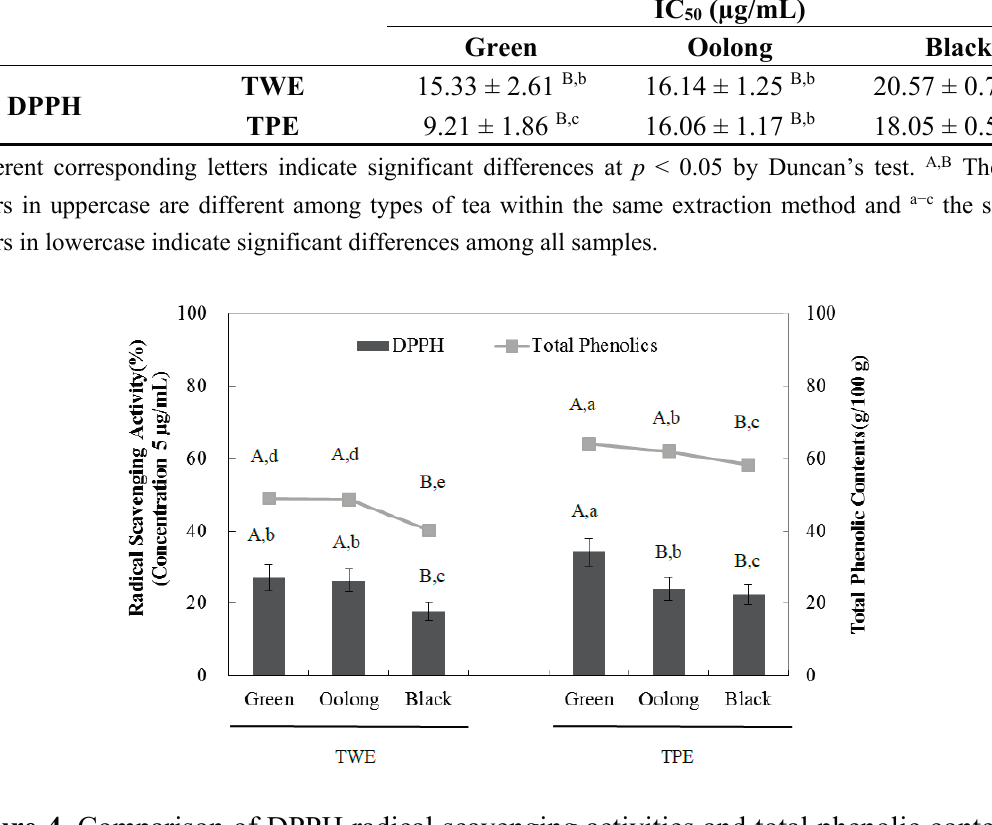
Figure 4. Comparison of DPPH radical scavenging activities and total phenolic content of tea water extract (TWE) and tea pomace extract (TPE) of green, oolong, and black tea at concentration 5.0 µg/mL concentration, The absorbance was measured at 517 nm for DPPH, and at 725 nm for total phenolic content. The results were expressed as mean ± S.D with three independent experiments in triplicate. Different corresponding letters indicate significant differences at p < 0.05 by Duncan’s test. A,B The first letters in uppercase are different among types of tea within the same extraction method and a − e the second letters in lowercase indicate significant differences among all